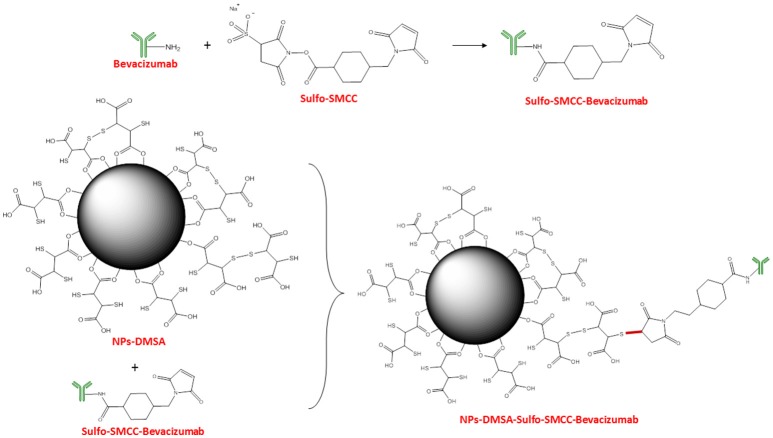
Schematic representation of Fe3O4-DMSA-SMCC-BCZM nanoparticles (FNs).